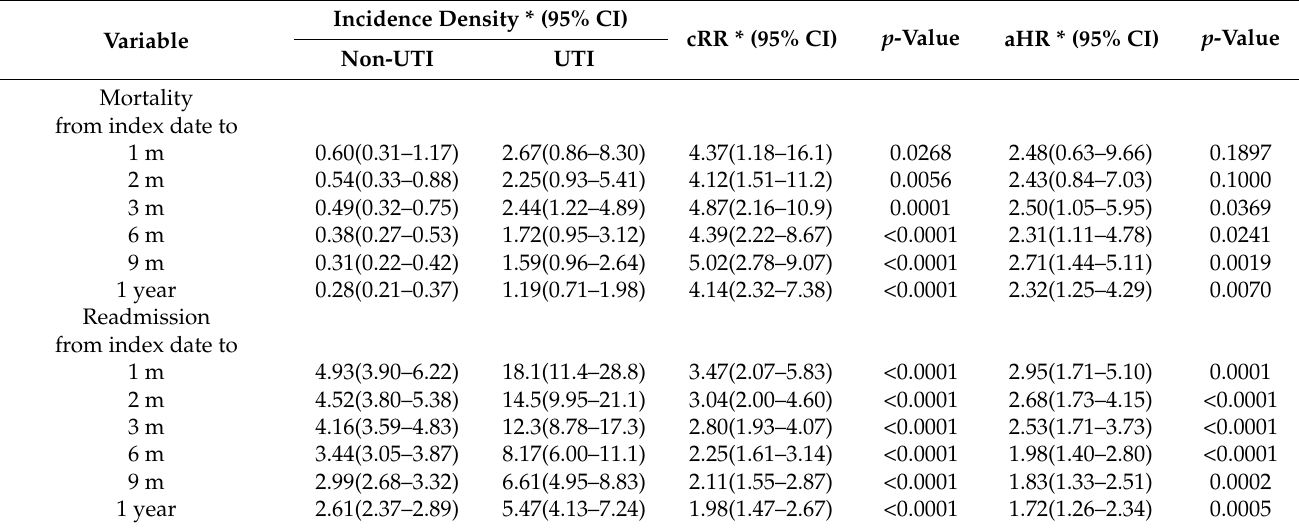
Table 2. Incidence rate for the mortality risk and re-admission.